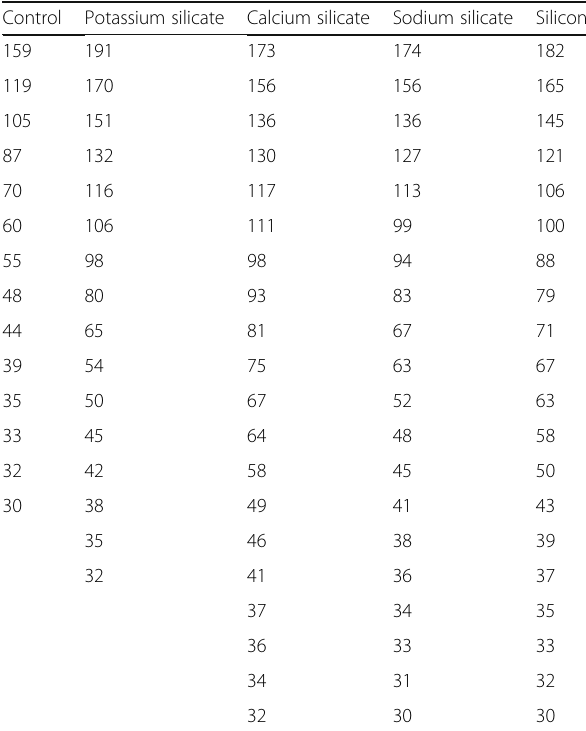
Table 5 Molecular weights for protein patterns of strawberry plants as affected with silicon and silicate salts analyzed using gelaxiralyzer 2010 program Control Potassium silicate Calcium silicate Sodium silicate